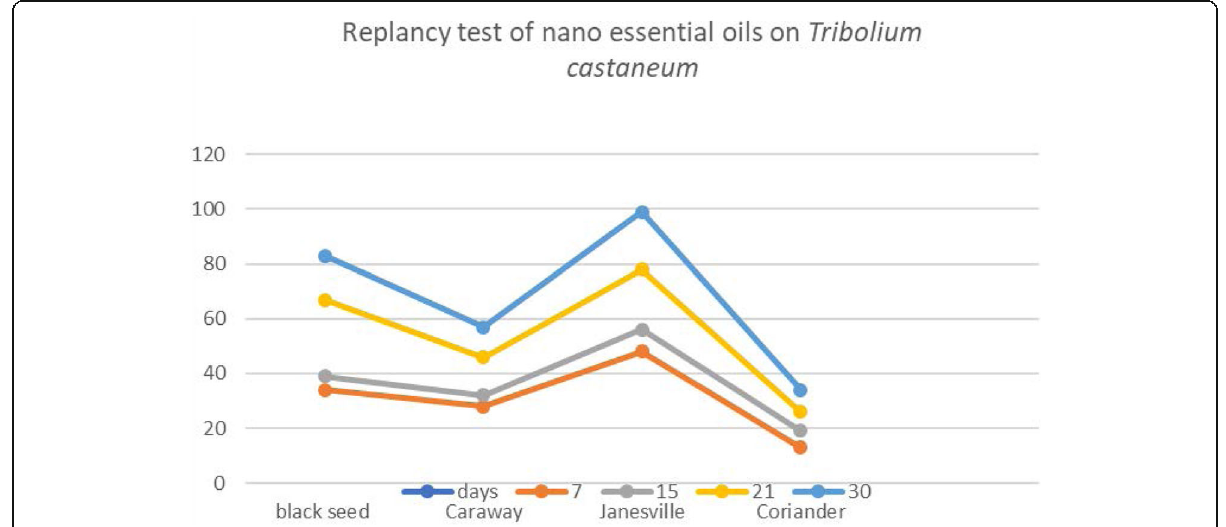
Fig. 1 The repellent activity of the tested essential nano-oils on T. castaneum